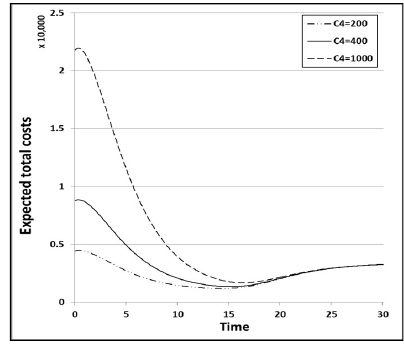
Figure 15. Expected total cost according to cost coefficient C 2 for the 2 nd condition.